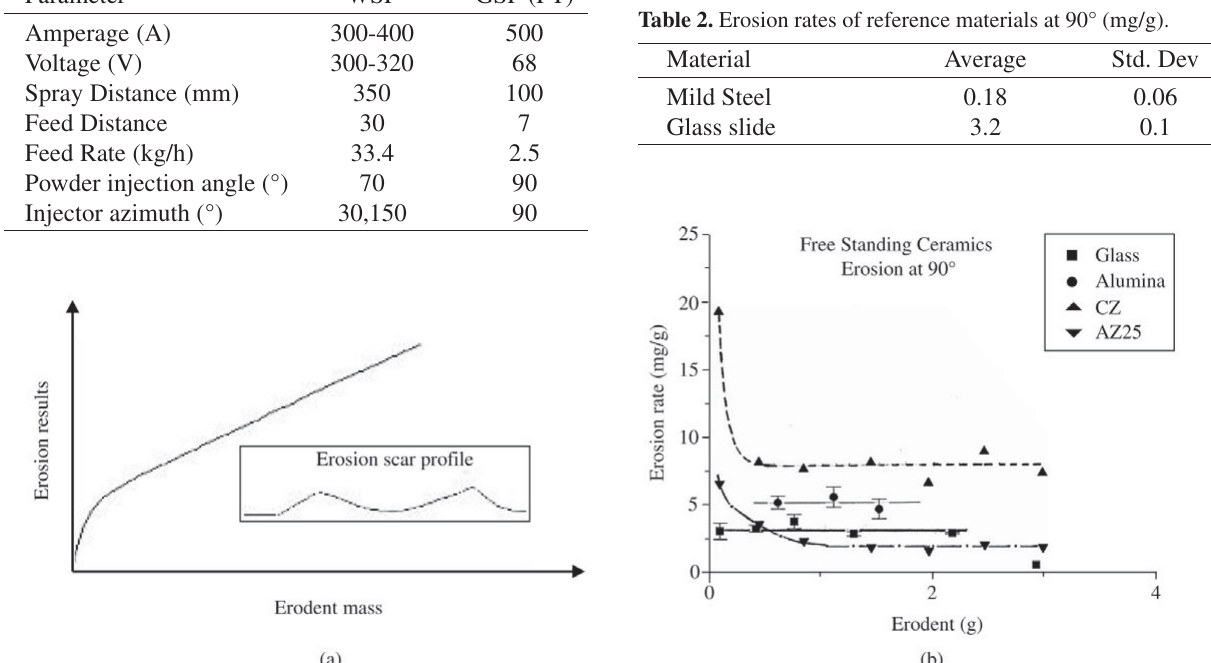
Table 1. Spray parameters.